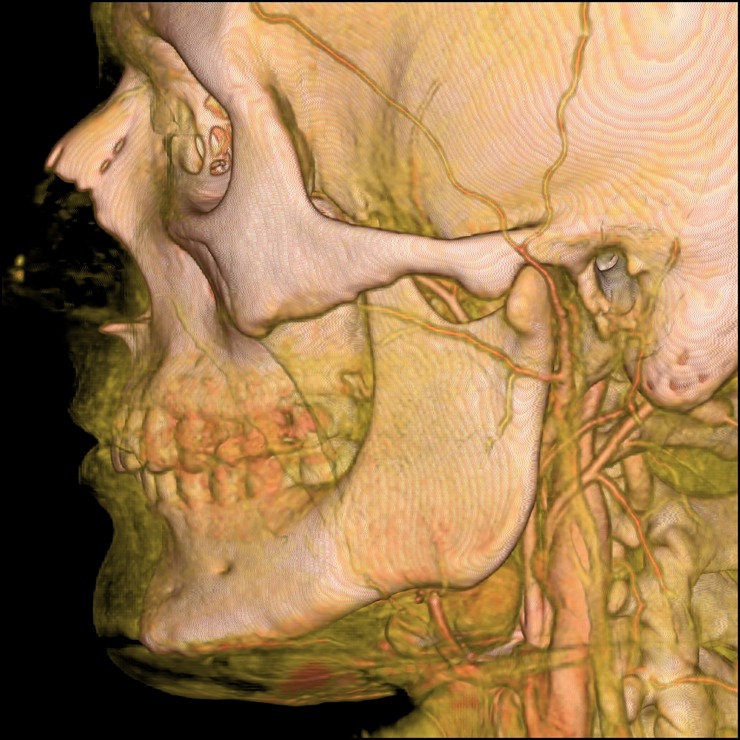
The computed tomography angiography (CTA) of the external carotid artery with three-dimensional (3D) volume-rendering showing typical single transverse facial artery (TFA) with masseteric branches.Black arrow indicates TFA.